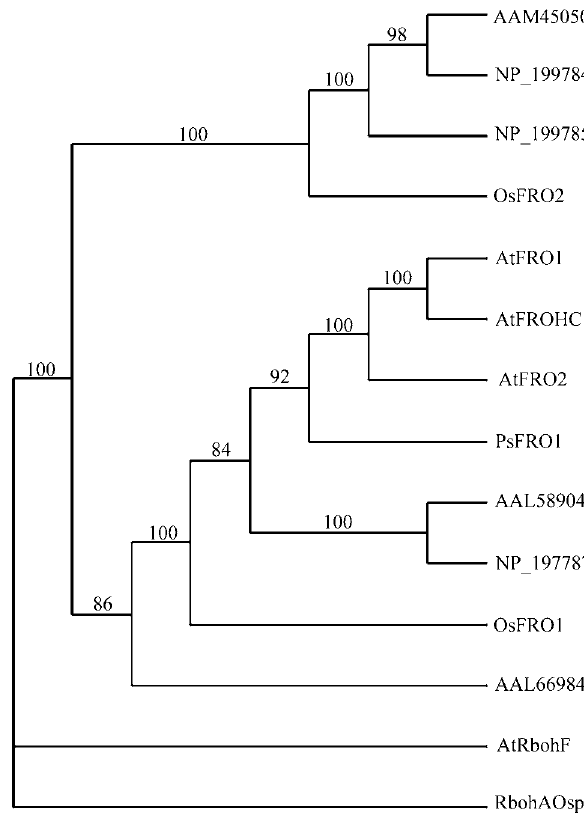
Figure 5 - Phylogenetic analysis of the ZIP protein family from Oryza sativa and Arabidopsis with Zinc regulated transporters ZRT1 and two from S. cerevisiae as outgroup. Accession numbers of nucleotide se- quences and corresponding predicted OsZIP proteins are shown in Table 3. Accession numbers to the other proteins are as follows: AtIRT1: AAB01678; AtIRT2: NP_193703; AtIRT3: NP_564766; AtZIP1: AAC24197; AtZIP2: AAC24198; AtZIP3: AAC24199; AtZIP4: NP_172566; AtZIP5: NP_172022; AtZIP6: NP_180569; AtZIP7: AAL38434; AtZIP8: AAL83293; AtZIP9: NP_195028; AtZIP10: NP_174411; AtZIP11: NP_564703; AtZIP12: NP_201022; ScZRT1: P32804; ScZRT2: